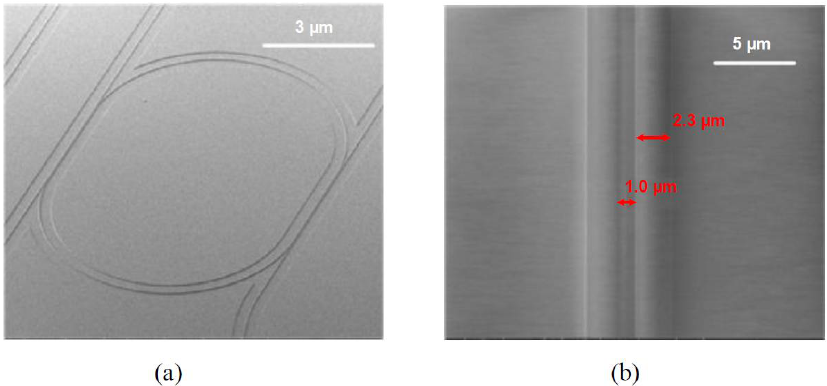
Figure 8. The SEM pictures of the racetrack microring resonator fabricated by the selective imprinting technique. ( a ) Image of the entire structure; ( b ) detail of the coupling region [36].